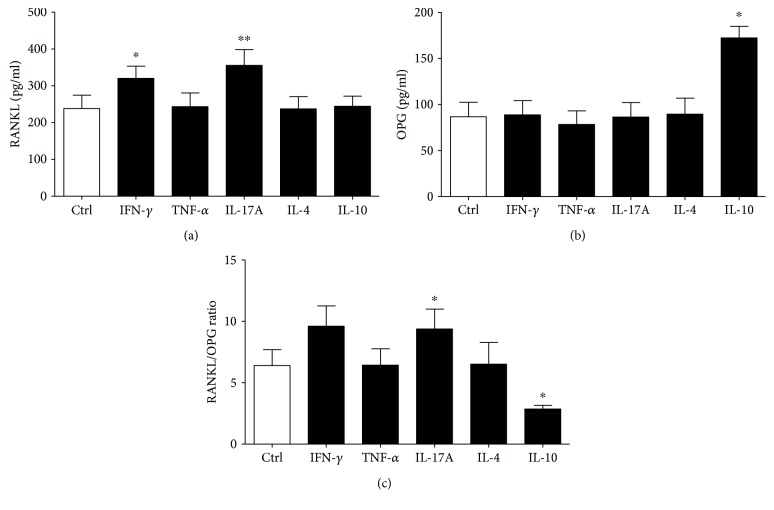
The levels of RANKL (a), OPG (b), and RANKL/OPG ratio (c) in PL cell cultures upon stimulation with pro- and anti-inflammatory cytokines. Periapical lesion (PL) cells were isolated from 12 PLs and cultivated for 24 hours with TNF-α, IFN-ϒ, IL- 17A, IL-4, and IL-10 as described in “Materials and Methods.” The levels of soluble RANKL and OPG in supernatants were measured by ELISA, and after that, the RANKL/OPG ratio was calculated. (a) Friedman test (n = 12, Friedman statistics 22.1, p = 0.0005) and Dunn's multiple comparison test, ∗p < 0.05 and ∗∗p < 0.01 vs Ctrl. (b) Friedman test (n = 12, Friedman statistics 15.94, p = 0.007) and Dunn's multiple comparison test, ∗p < 0.05 vs Ctrl. (c) Friedman test (n = 12, Friedman statistics 21.14, p = 0.0008) and Wilcoxon signed-rank test, ∗p < 0.05 compared to Ctrl.